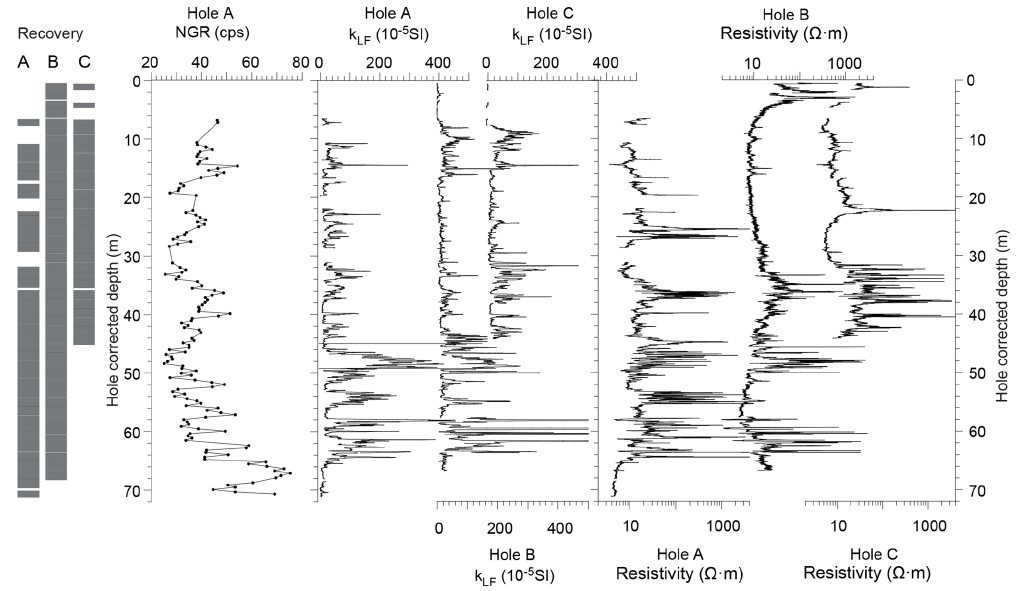
Figure 3. Core recovery log for each core hole and whole core MSCL-scanning data. Grey indicates full recovery, and white indicates no recovery. Natural gamma ray (NGR) was measured at 40cm intervals, and volumetric magnetic susceptibility ( k LF ) and resistivity were measured at 1m